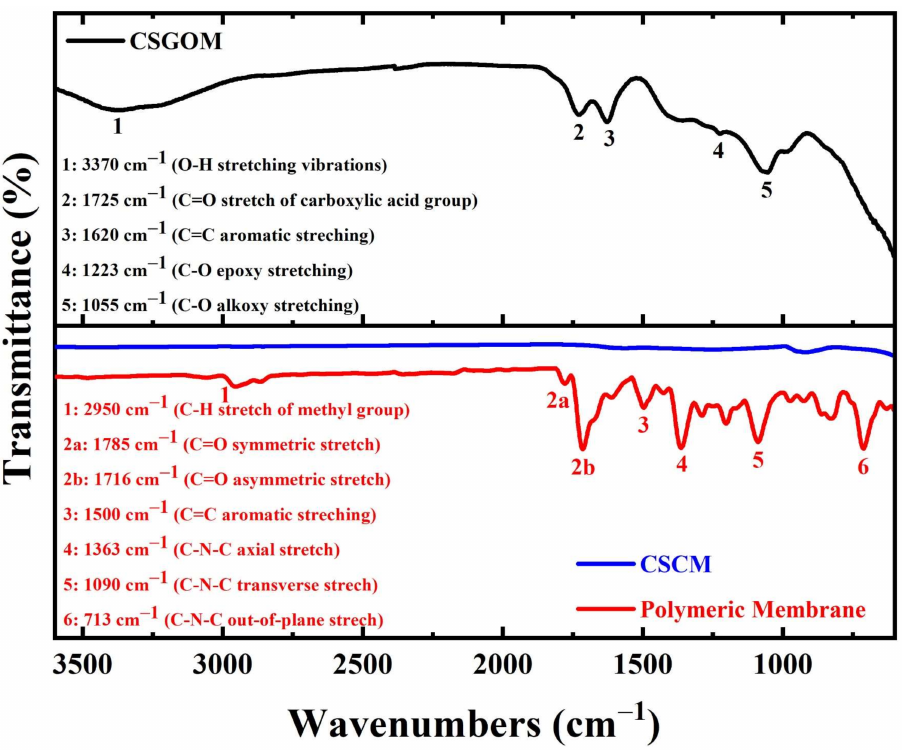
Figure 2. FTIR spectra of the polymeric membrane, CSCM and CSGOM (CSCM: 10% wt. Matrimid and CSGOM: 1 mg · L − 1 GO